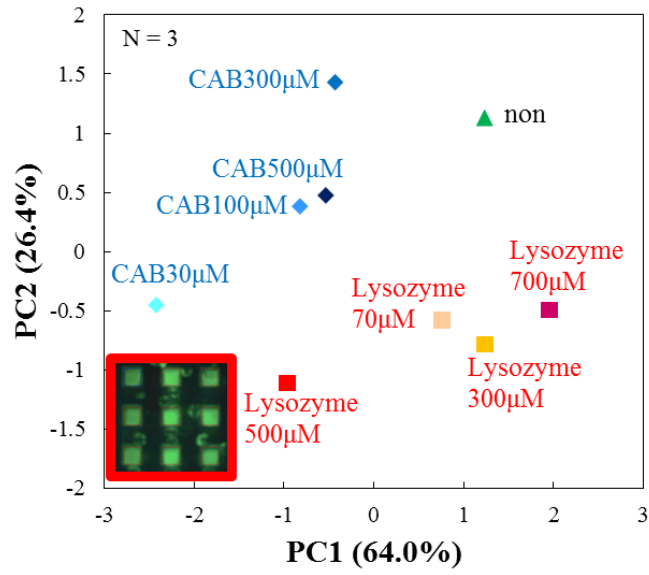
Figure 6. PCA score plot (N = 3) from averaged RF’s of DPPC, DSPC and DPPC/cholesterol after 60 min from the initial addition of target proteins by a single-shot of arrayed microwells.